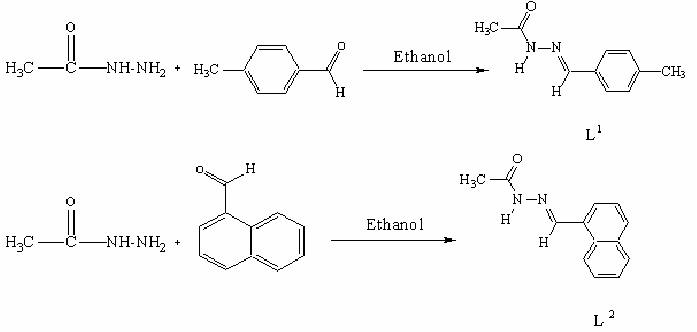
Figure 1. Synthesis of